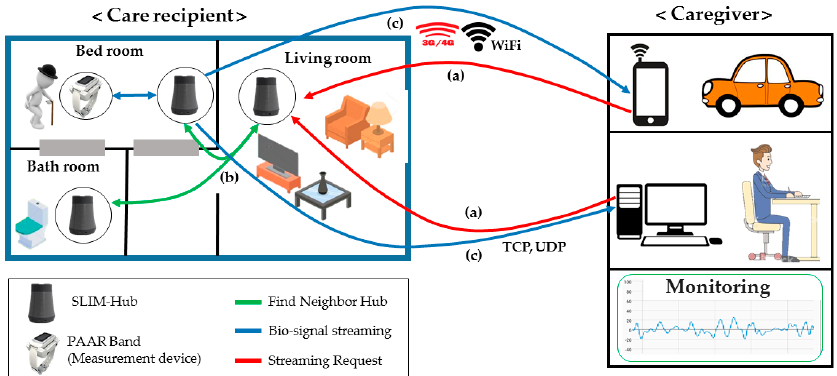
Figure 6. Monitoring and Streaming service scenario. ( a ) Monitoring and Streaming request; ( b ) Lookup neighbor SLIM hubs; ( c ) Streaming to the remote caregiver.